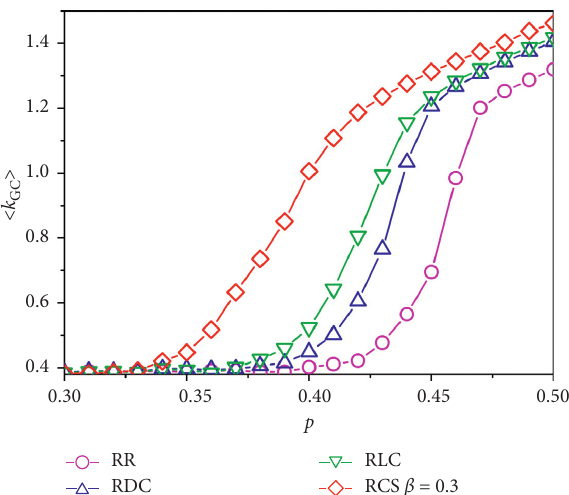
Figure 9: The average degree < k GC > of remaining networks in the steady state as a function of the fraction of surviving nodes p on the ICNs with ER-ER structures.